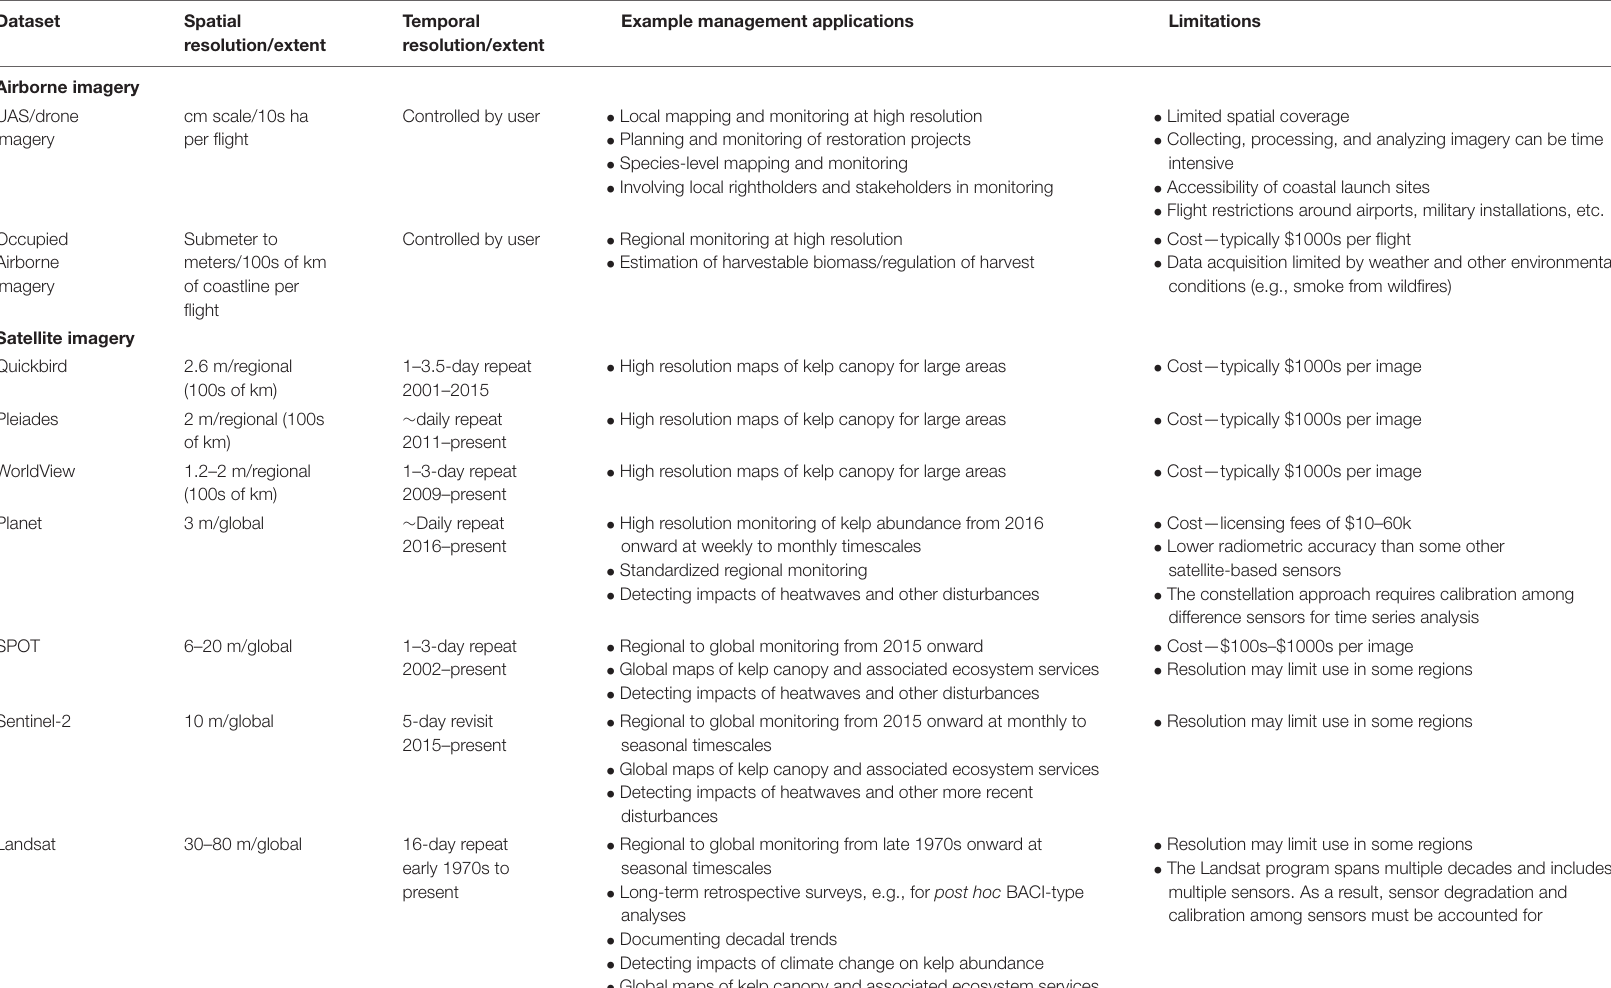
TABLE 2 | List of remote sensing data that has been used for monitoring surface canopy-forming kelps.